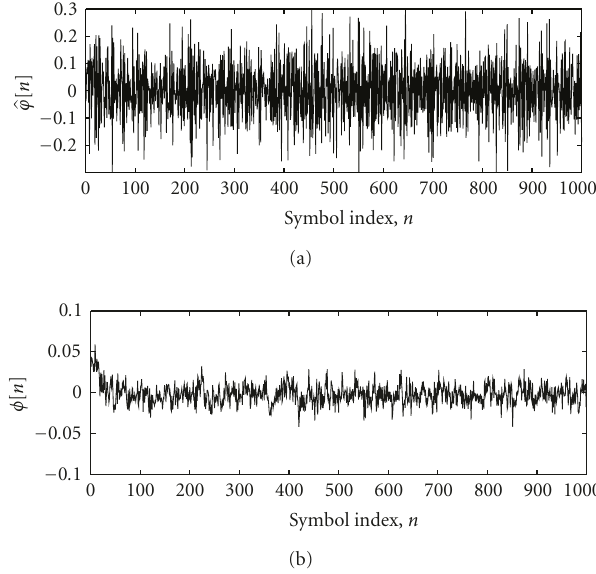
Figure 10: Performance of the PLL for carrier tracking in a CMT receiver. The top figure shows the phase error, ϕ [ n ], at the loop filter input. The lower figure shows the phase jitter, φ [ n ], of the input signal to the analysis filter bank. Note that the vertical scales in two plots are di ff